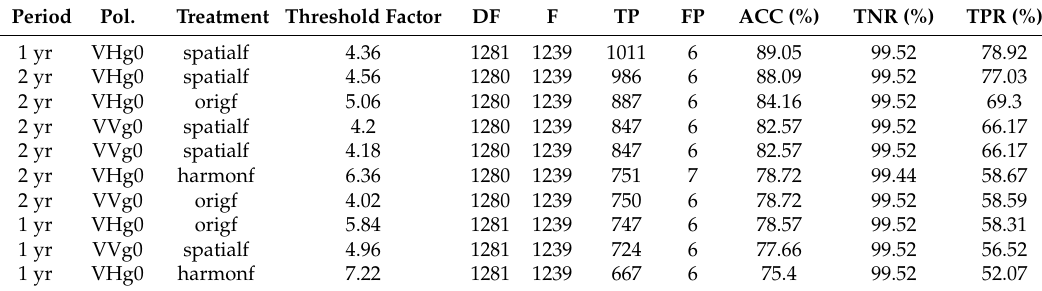
Table 5. Final results of the MLC detection with a fixed TNR~99.5% (0.5% of false positives), ordered by TPR. Only the 10 top results shown. DF = Number of deforested TS; F = Number of forest TS; TP = True positives; FP = False positives; TNR = True Negative Rate; TPR = True Positive Rate; ACC = Global